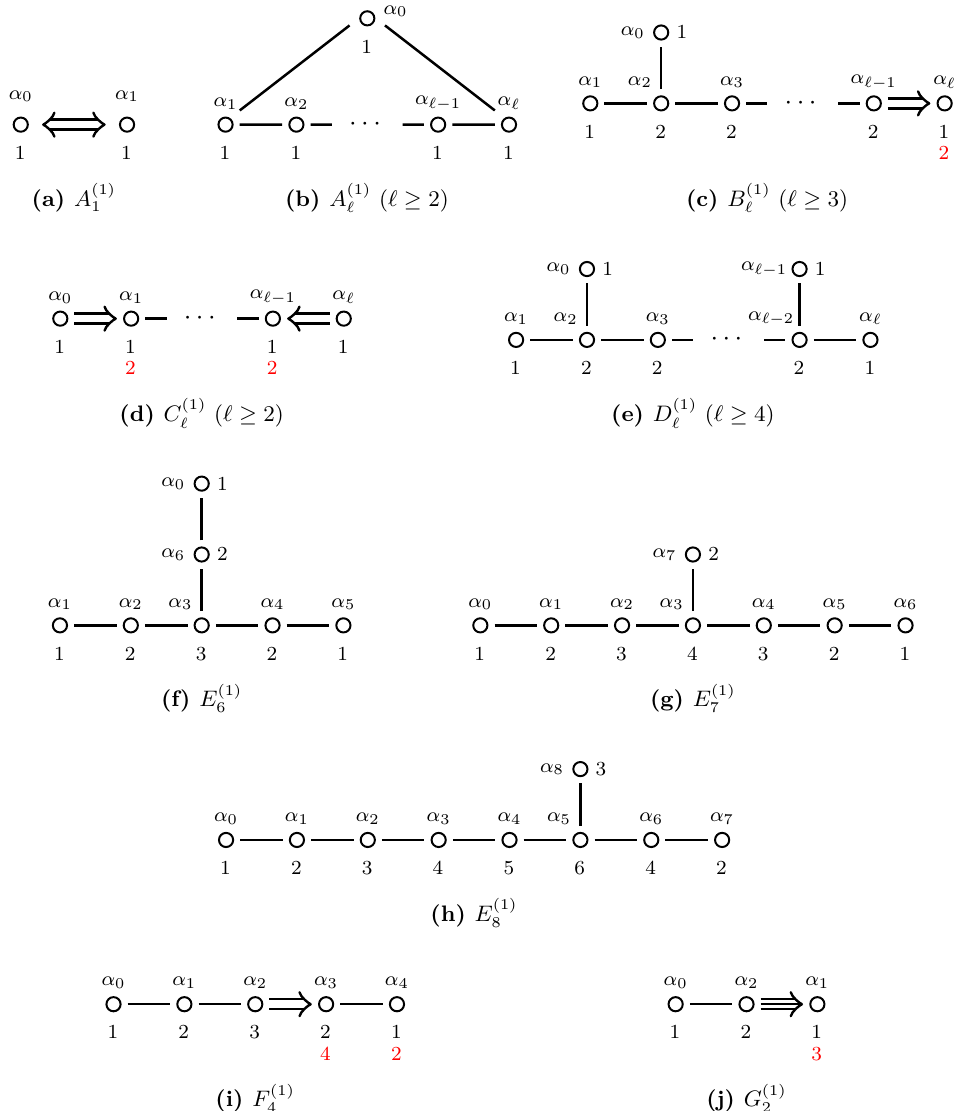
Figure 7. Dynkin diagrams of untwisted affine Lie algebras X (1) the dual Coxeter label (comark) d ∨ as a red number. Dynkin diagrams without the affine node α 0 reduce to the Dynkin diagrams of simple Lie algebras X ‘